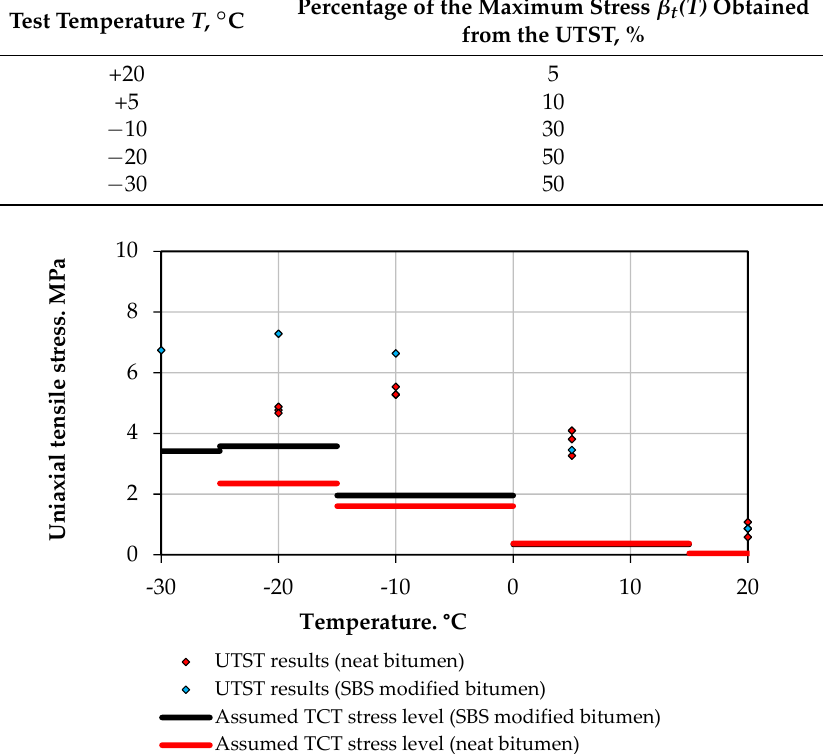
Figure 2. Stress levels at test temperatures applied in the Tensile Creep Test (TCT).